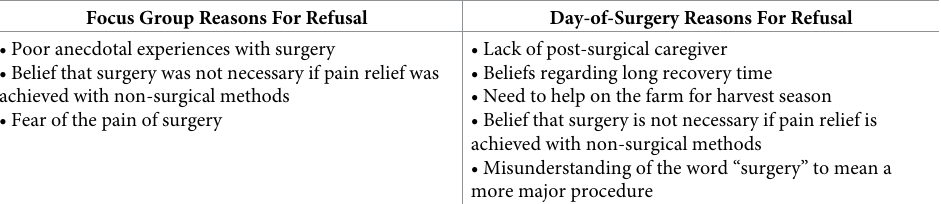
Table 3. Reasons for refusal: Comparison between focus groups and Day-of-Surgery